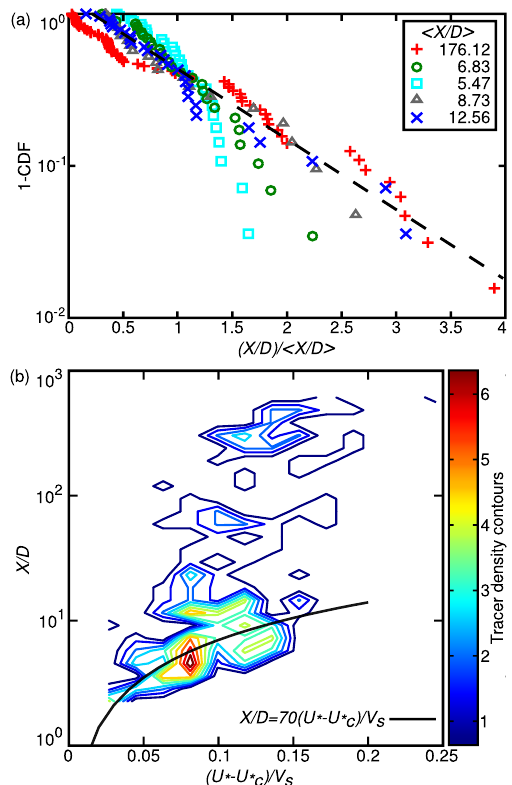
Figure 7. (a) Dimensionless displacement distributions for individ- ual floods normalized by the mean ( (cid:104) X/D (cid:105) ) displacement for that flood. The black dashed line is an exponential distribution. Dimen- sionless mean displacement lengths for each flood are labeled in the legend. (b) Contour density plot of X/D against the excess shear velocity normalized by the settling velocity for each tracer. The con- tour colors represent the density of tracers within that location. The value of U ∗ is for the flood peak, while the value of U ∗ c is treated as a fitting parameter. The black line represents the expected linear re- lationship between the dimensionless shear velocity and the modal tracer step length (Eq.